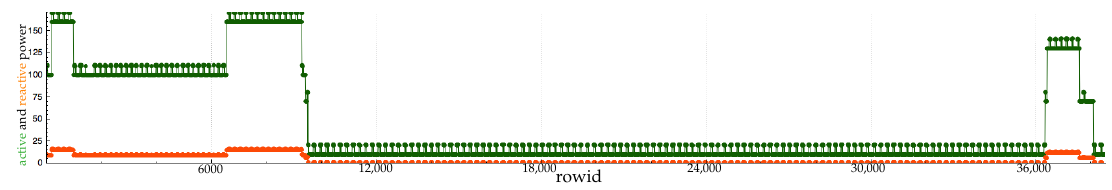
Figure 18. Evolution of electricity consumption in phase 2.